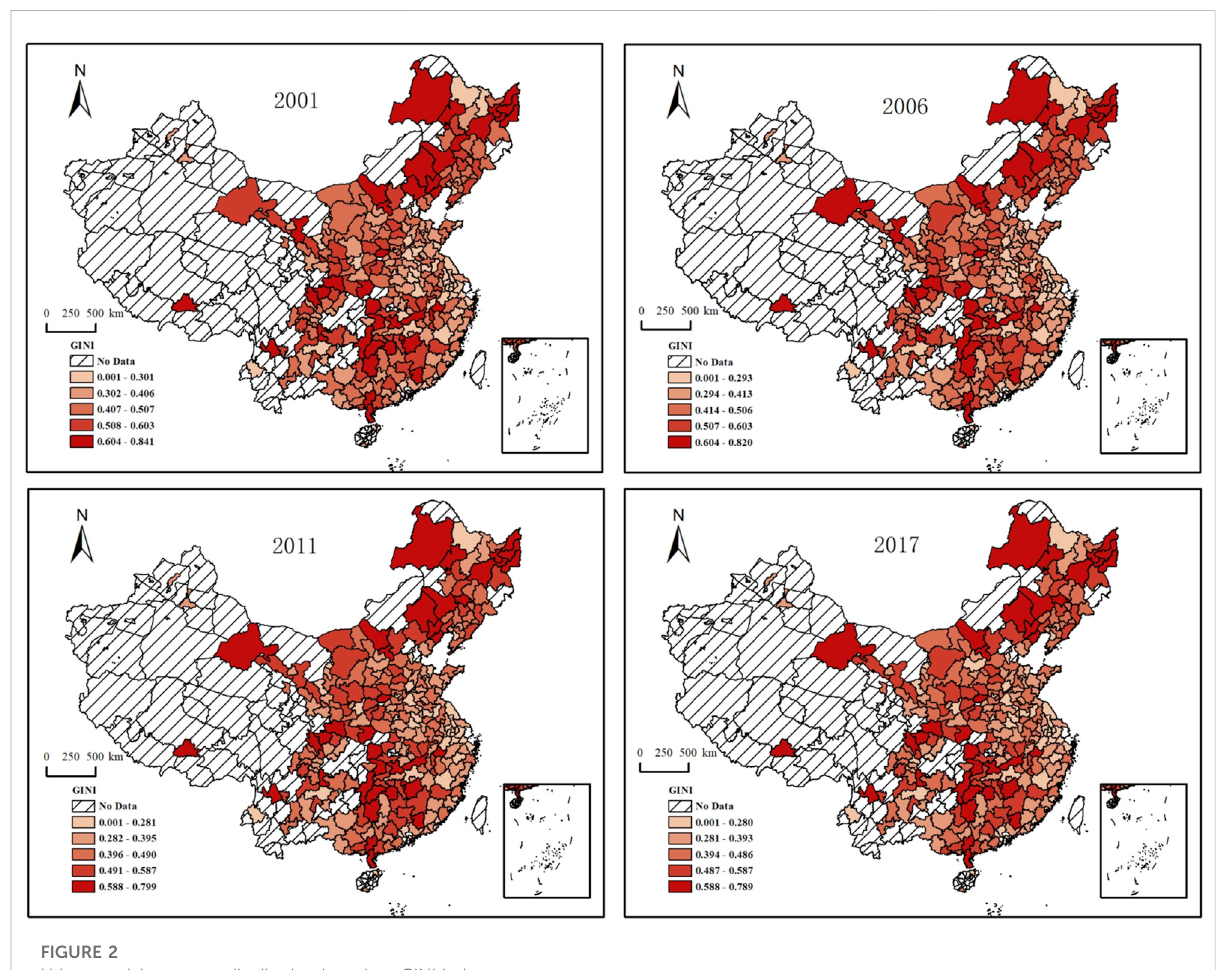
FIGURE 2 Urban spatial structure distribution based on GINI index.